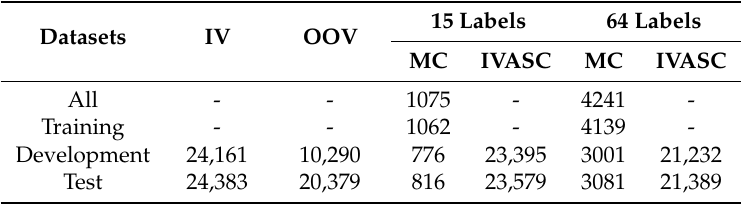
Table 8 illustrates the performances of BI-LSTM-CRF models on different subsets of words. The results of CRF model are provided as a